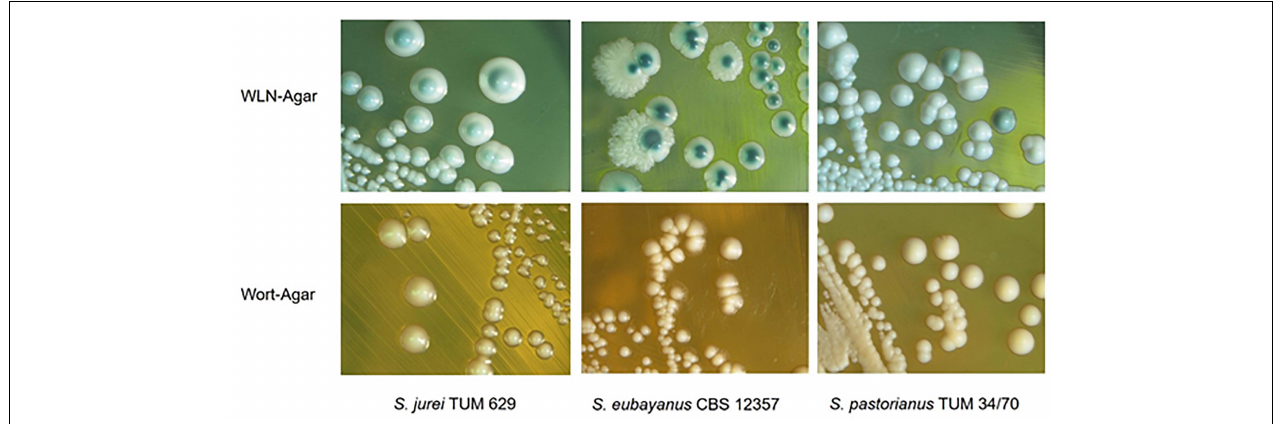
FIGURE 1 | Colony morphologies of S. jurei TUM 629, S. eubayanus C902, S. pastorianus TUM 34/70 on WLN-Agar (Wallerstein-Nutrient-Agar) and Wort-Agar.